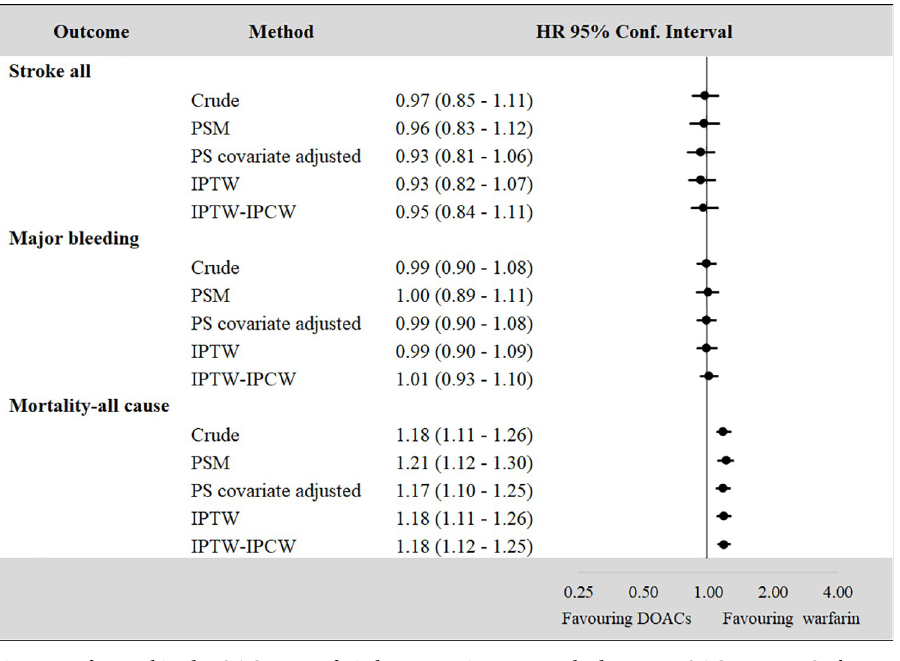
Fig 4. HRs for combined-DOACs vs. warfarin by propensity score methods. Note: DOACs = Direct Oral Anticoagulants, PS = Propensity Score, PSM = Propensity Score Matching, IPTW = Inverse Probability of Treatment Weighting (IPTW), Inverse Probability of Censoring Weighting